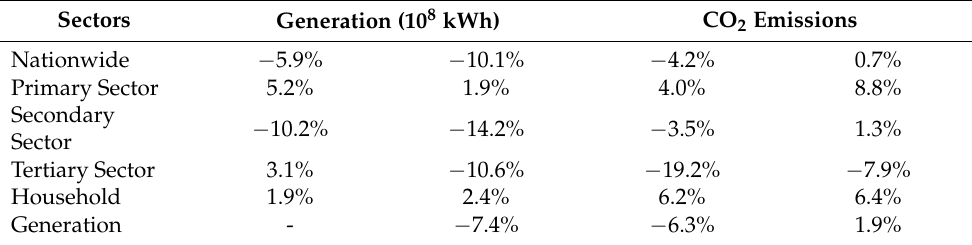
Figure 3. Changes of consumptive-electricity related CO 2 emissions in January–April 2020. The daily existing confirmed COVID-19 cases in Mainland China is included. Table 5. Consumptive carbon footprint changes (%) in January–April 2020, compared with same month of